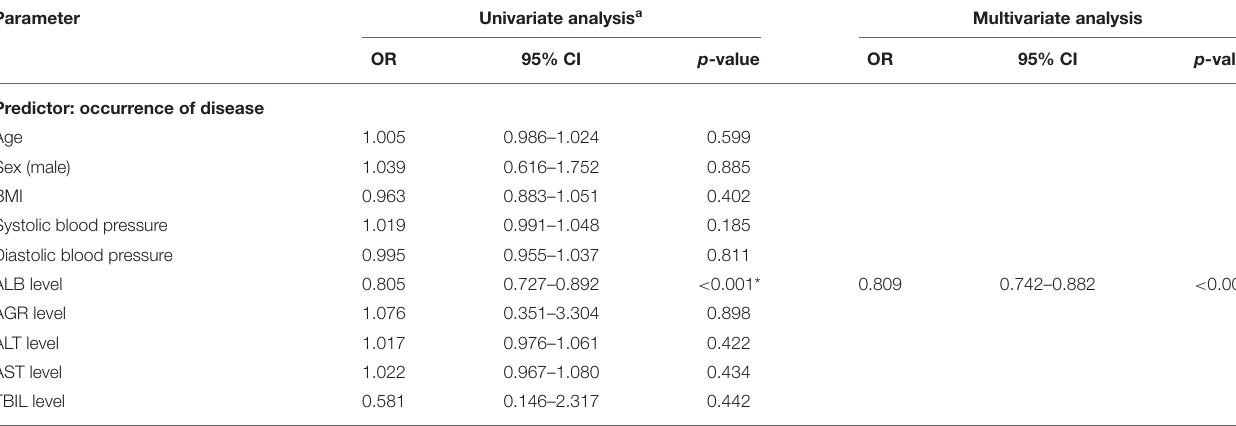
TABLE 2 | Binary logistic regression analysis of the relationship between liver function levels and the occurrence of SSNHL.